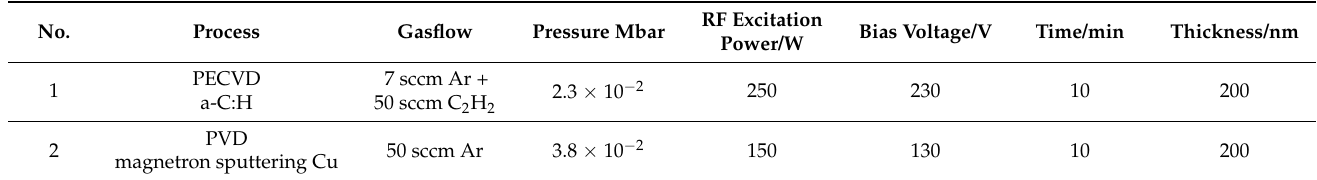
Table 1. Process parameters of the PECVD/PVD process for a-C:H/Cu-multilayer deposition.